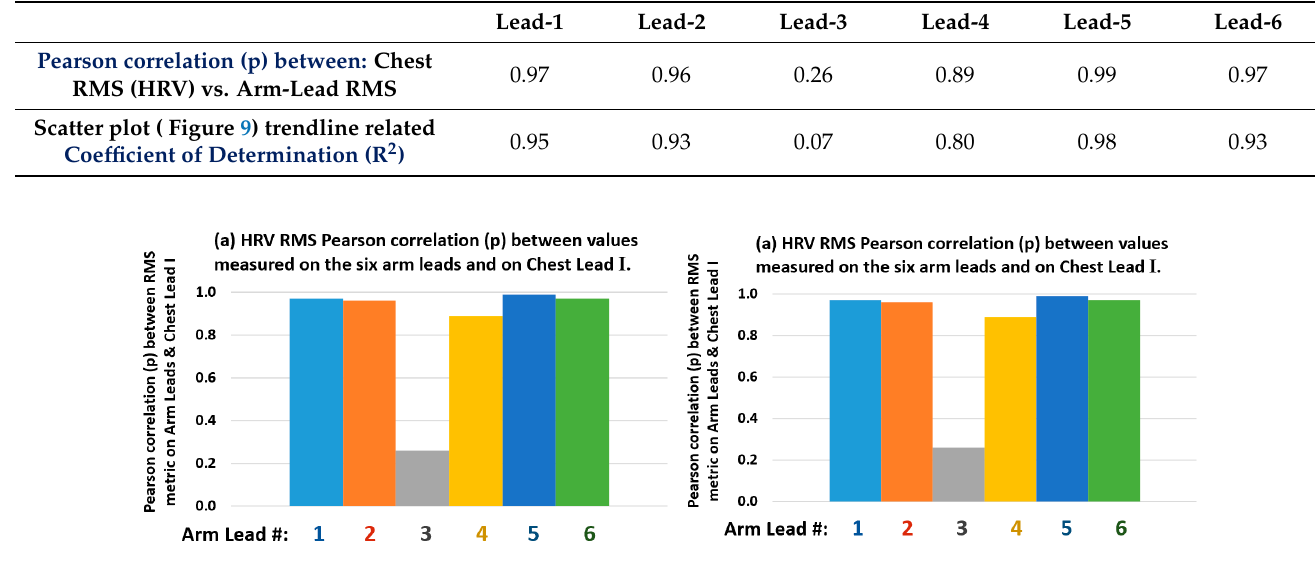
Figure 8. Bar charts for results in Table 6: arm leads (1–6) HRV RMS metric values versus measured HRV RMS values in the Chest Lead I: ( a ) Pearson correlation (p), and ( b ) trendline (Figure 9) coefficient of determination (R 2 ).